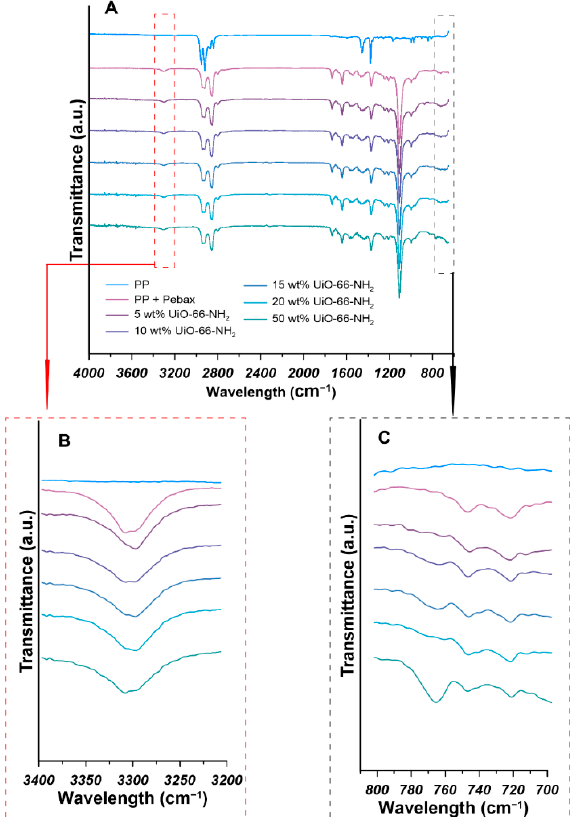
Figure 8. FTIR (Fourier transform infrared) spectra of Pebax ® 2533-UiO-66-NH 2 /PP thin film mixed matrix hollow fiber membranes ( A ) (the enlarged FTIR spectra in the wavelength range 3400–3200 cm − 1 and 800–700 cm − 1 are shown in ( B ) and ( C ), respectively).